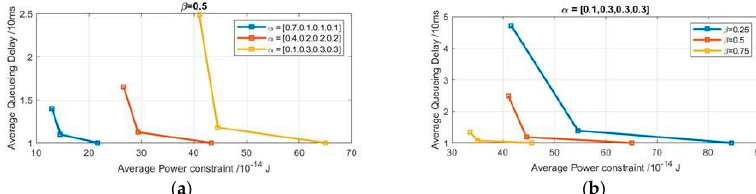
Figure 5. Realistic channel state condition channel-aware tradeoff curve for ( a ) 𝛽 = 0.5 , ( b ) for 𝛼 = [0.1,0.3,0.3,0.3] .